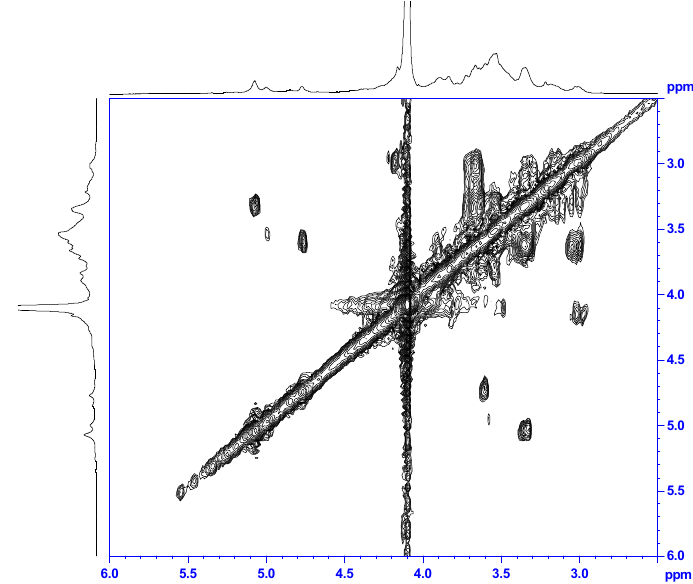
Figure 4. 2D 1 H- 1 H COSY NMR correlation spectra of the JSP fraction. The analyses were recorded at 40 g/L in D 2 O solution at 60 °C.